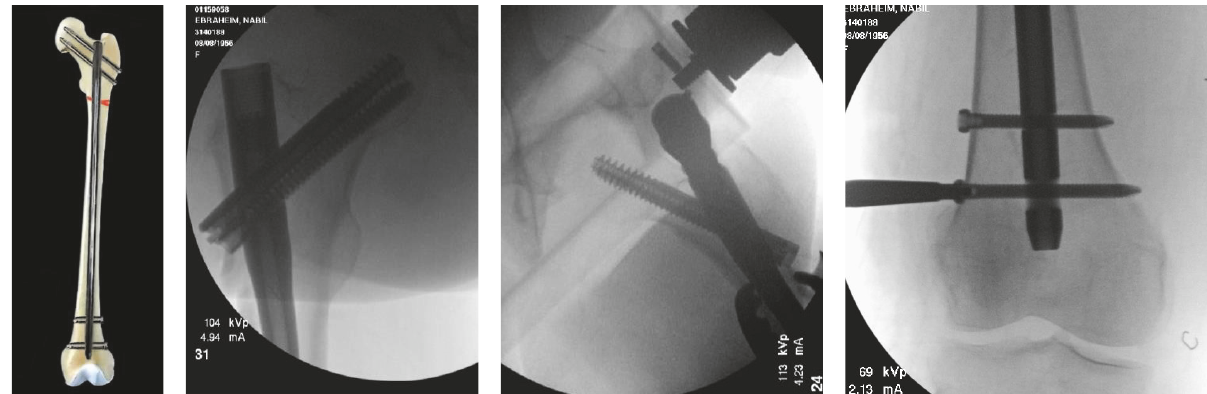
Figure 4: Intramedullary fixation of a subtrochanteric femur fracture: This diagram illustrates and provides radiographs of an example of intramedullary fixation of a subtrochanteric femur fracture. Proximal fixation is achieved through the use of cephalomedullary screws and distally with locked interlock screws.